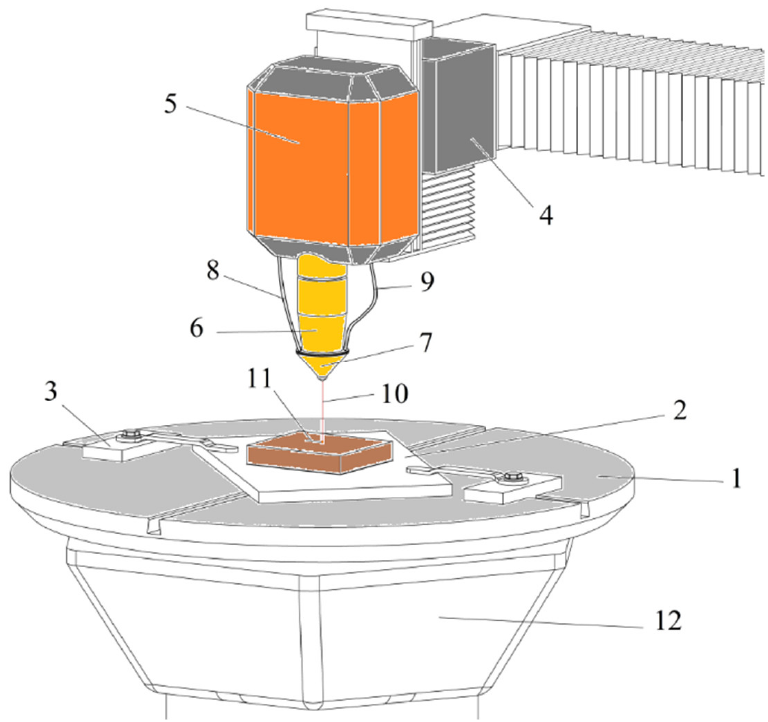
Figure 3. The design of LDED equipment: 1—table, 2—substrate, 3—mountings, 4—X–Y movement system, 5—laser module, 6—laser head, 7—coaxial nozzle, 8—powder feeding channels, 9—shield